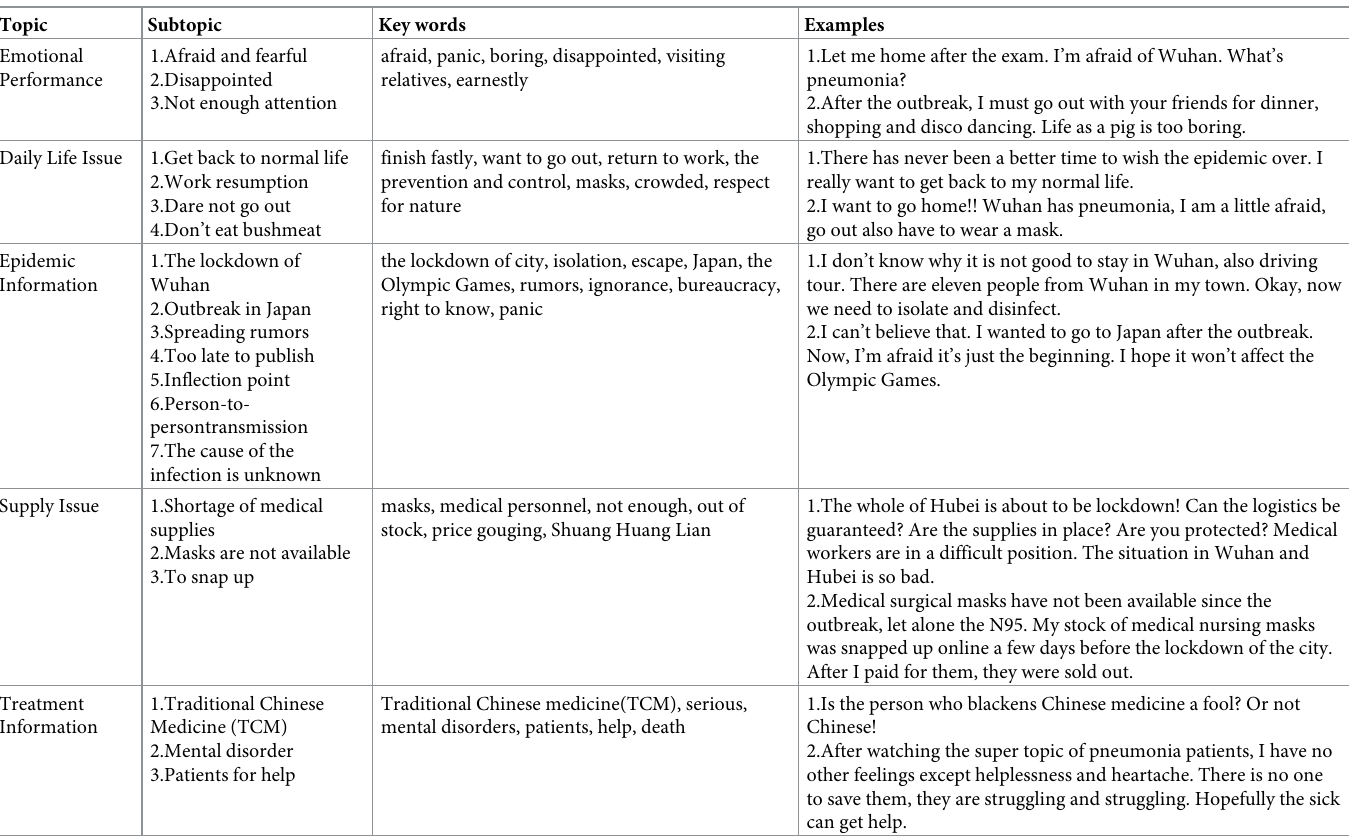
Table 3. The topics, key words and examples of negative sentiment.